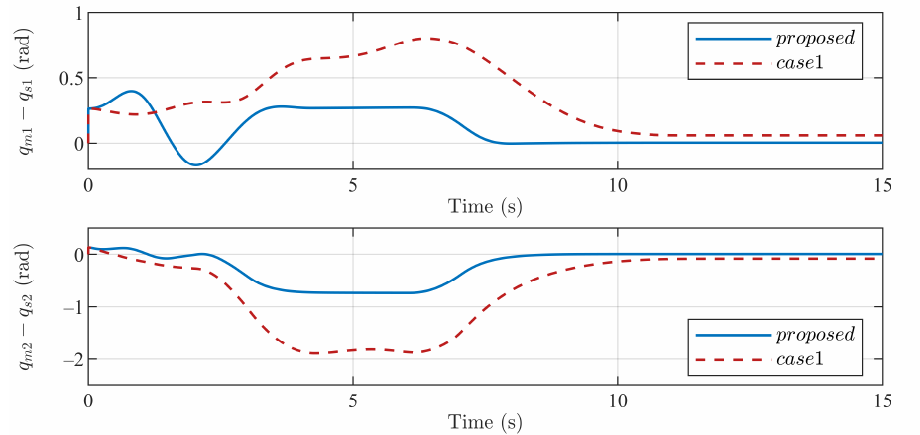
Figure 13. Comparisons of joint tracking errors with the proposed method and Case 1.